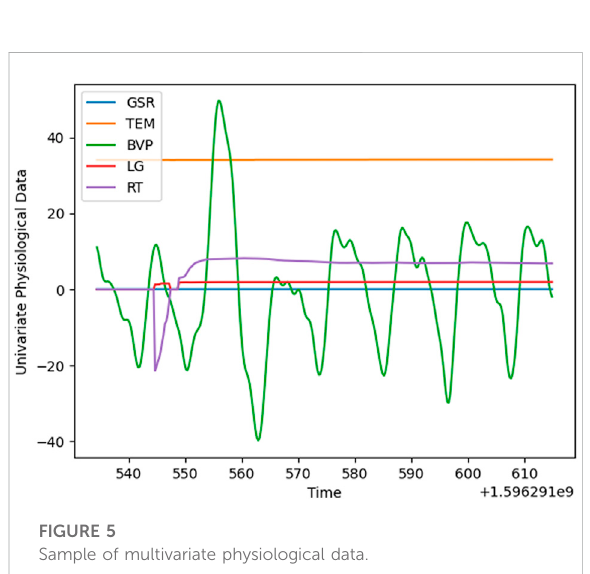
FIGURE 5 Sample of multivariate physiological